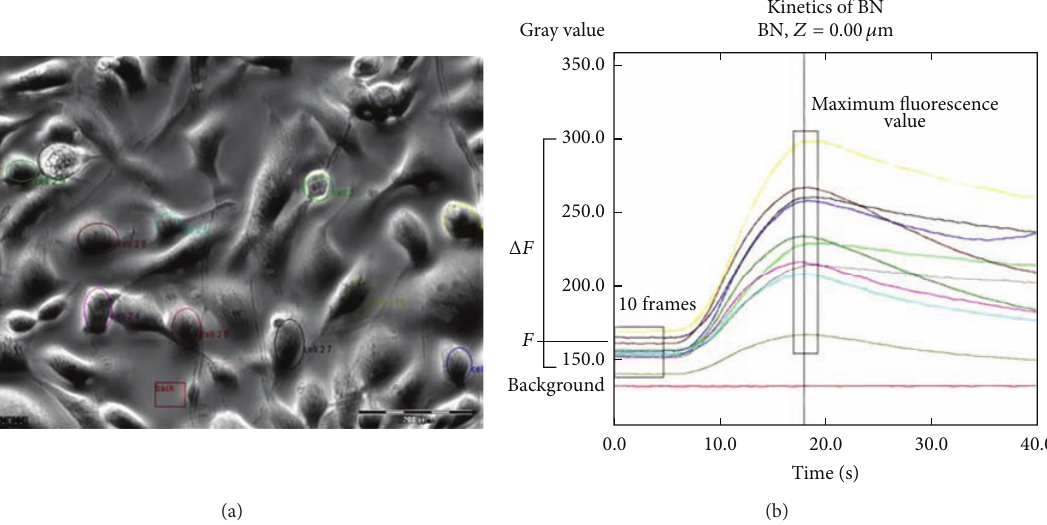
Figure 1: Calcium imaging data analysis. The regions of interest (ROIs) of 10 cells per plate (colored ellipsis) are marked to measure changes in fluorescence and a ROI without cells (dark red rectangle) is also marked to measure the background signal (a). Increases in fluorescence are plotted as a time function for each cell. The increase of fluorescence ( Δ𝐹 ) is calculated as the difference between the mean of the peak and 2 frames backward and forward (narrow rectangle measurements) and the mean of the measurements of 10 frames before agonist exposition (wide rectangle of measurements); the background signal (red line) is then subtracted